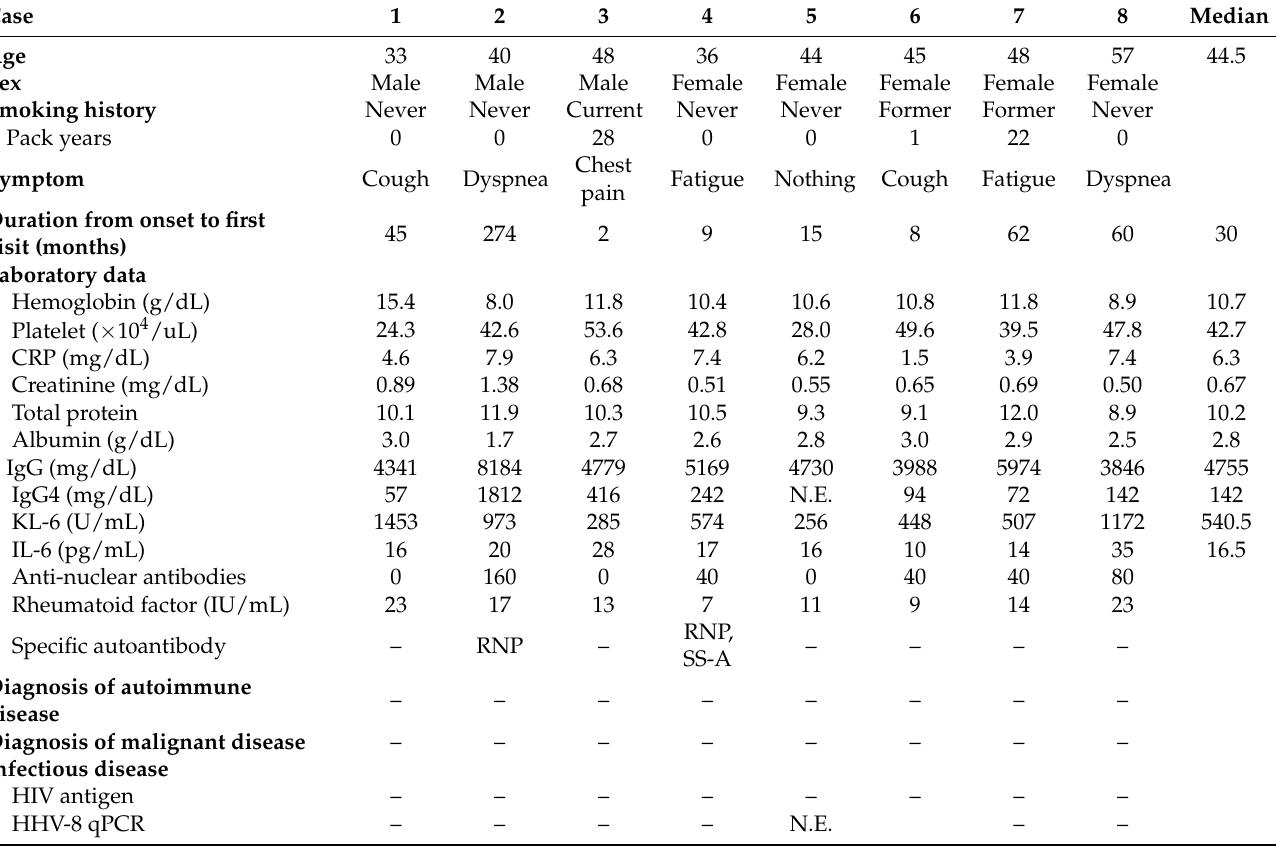
Table 1. Summary of Patient Characteristics of 8